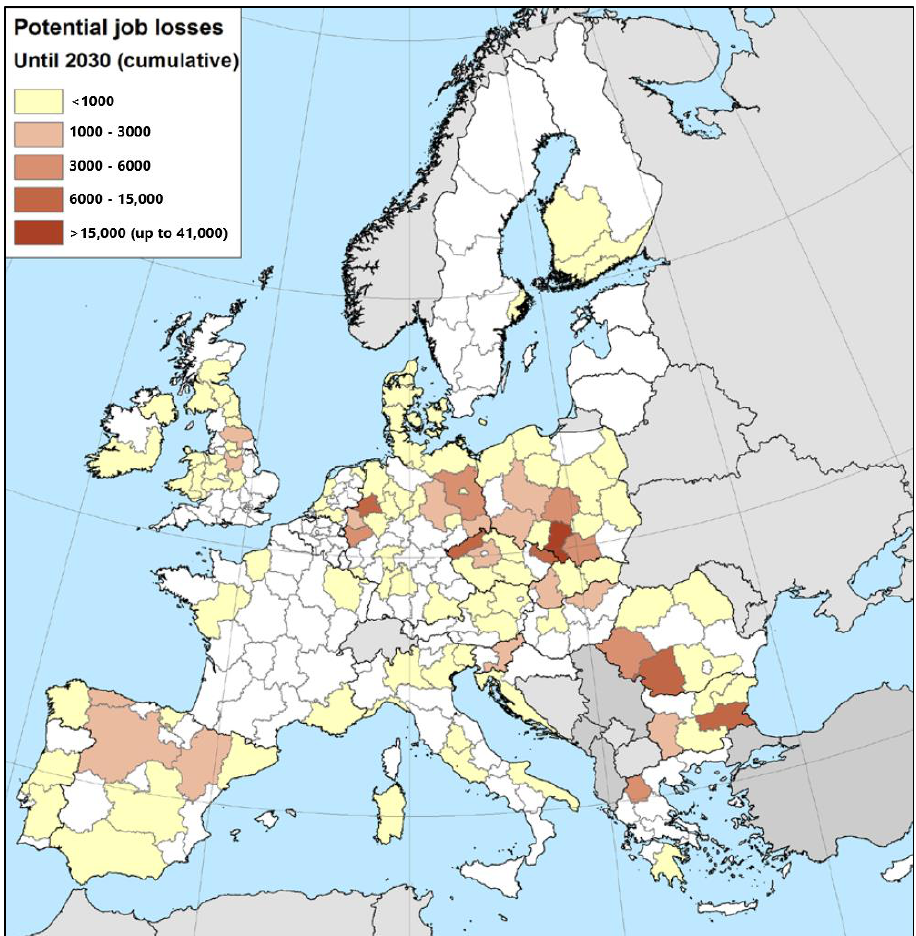
Figure 1. Potential job losses caused by the closure of coal mines in the EU [6].